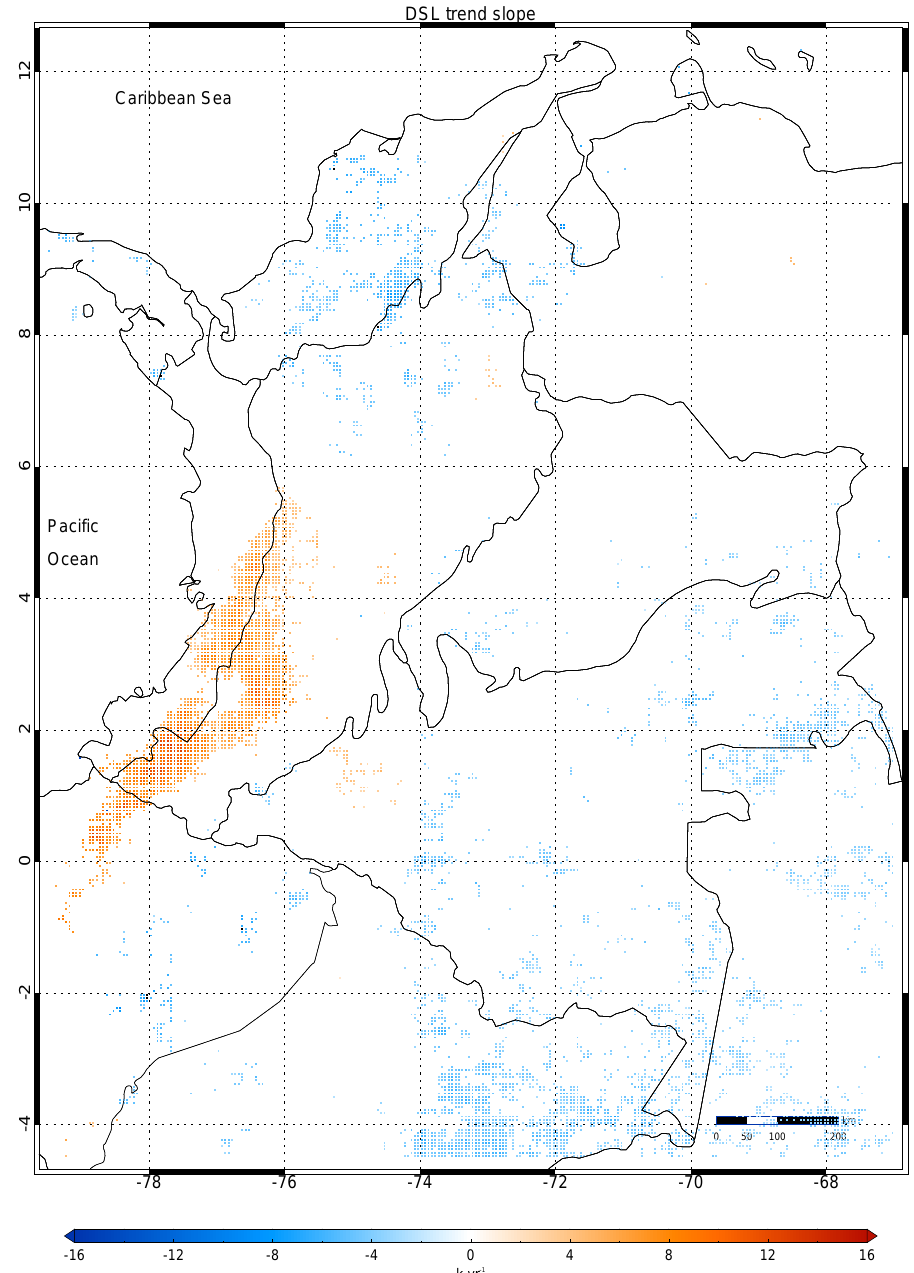
Figure 7. Map of the trend slope for DSL for CHIRPS dataset. Non-significant trends are not plotted for CHIRPS. Color scale in kyr − 1